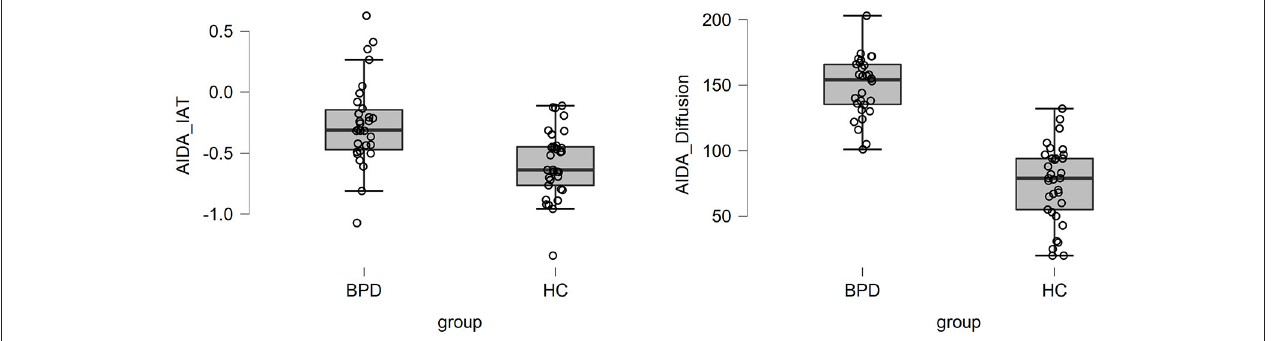
FIGURE 1 | Boxplots with single case values of AIDA-IAT and total AIDA-Identity diffusion scores for patients with BPD and adolescents with a healthy personality